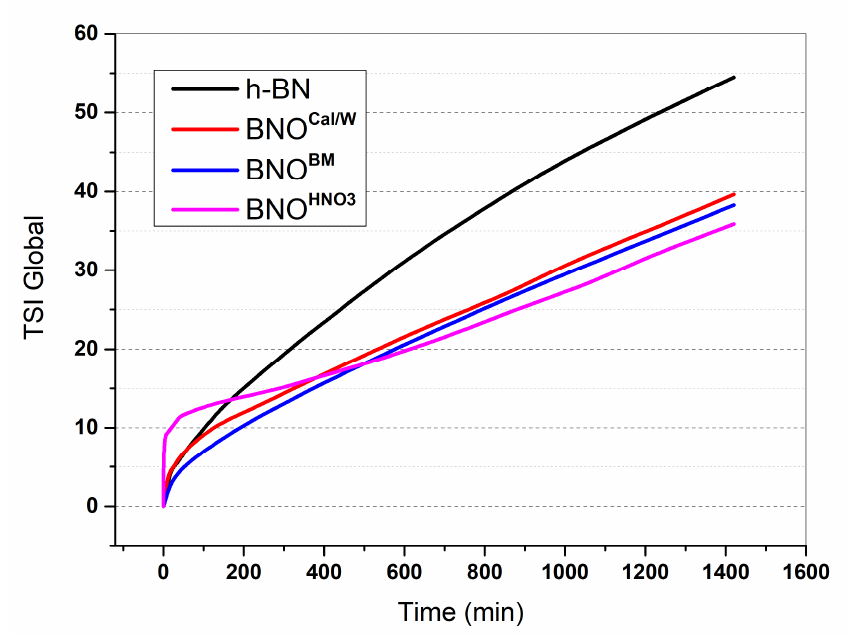
Figure 6. Turbiscan Stability Index (TSI) global stability of raw h-BN and hydroxylated boron ni-